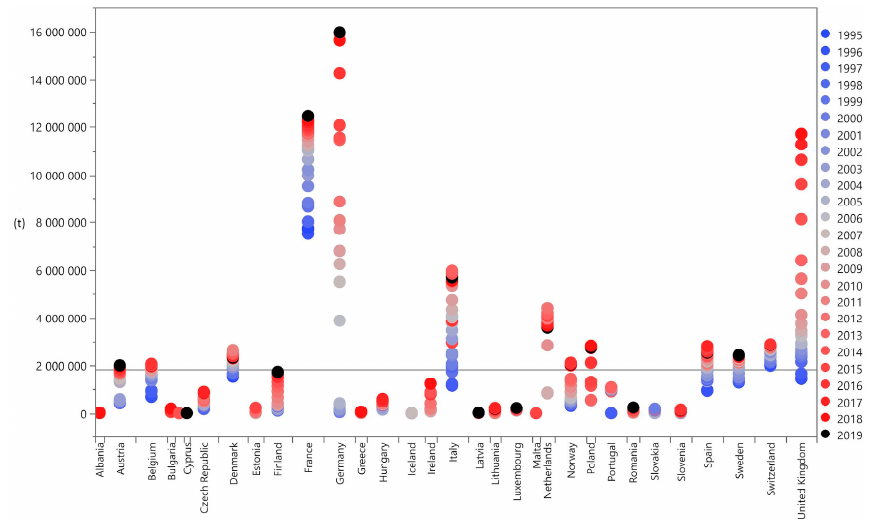
Figure 3. Sample point graph—energy recovery from municipal waste in the EU 1995–2019.